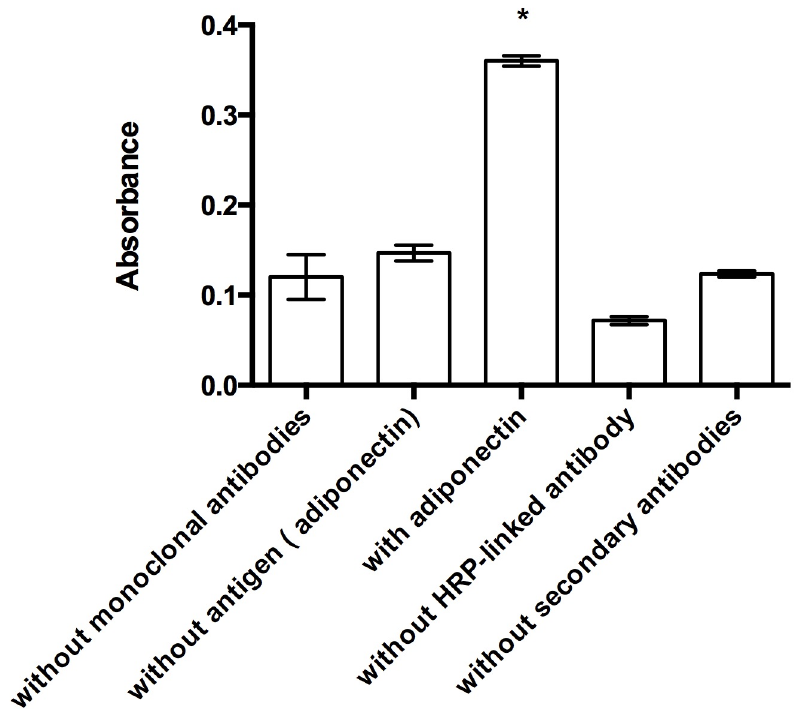
Figure 10. Controls for ELISA using florescence detection (one-way ANOVA analysis; “*” denotes the significant result within p <